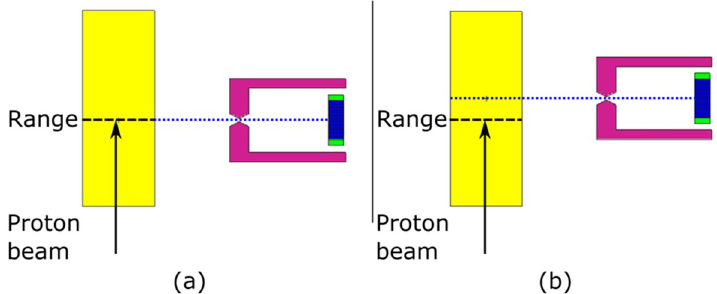
Figure 2. Setups for the MC simulations. The proton beam impinges on the water phantom (yellow) and the prompt gammas are detected through the tungsten collimator (pink) by the photodetector (blue). ( a ) The setup used for the simulation of the normal profile, that is, with the central imaging plane of the camera (i.e., pair 10/11, resembled by the blue dotted line) aligned with the proton range (black dashed line). ( b ) One of the individual steps of the simulation of the reconstructed profile. The central pair is placed in the position of pair 19/20 with respect to the nominal case shown in ( a ). The simulation was developed by Smeets et al. [7].